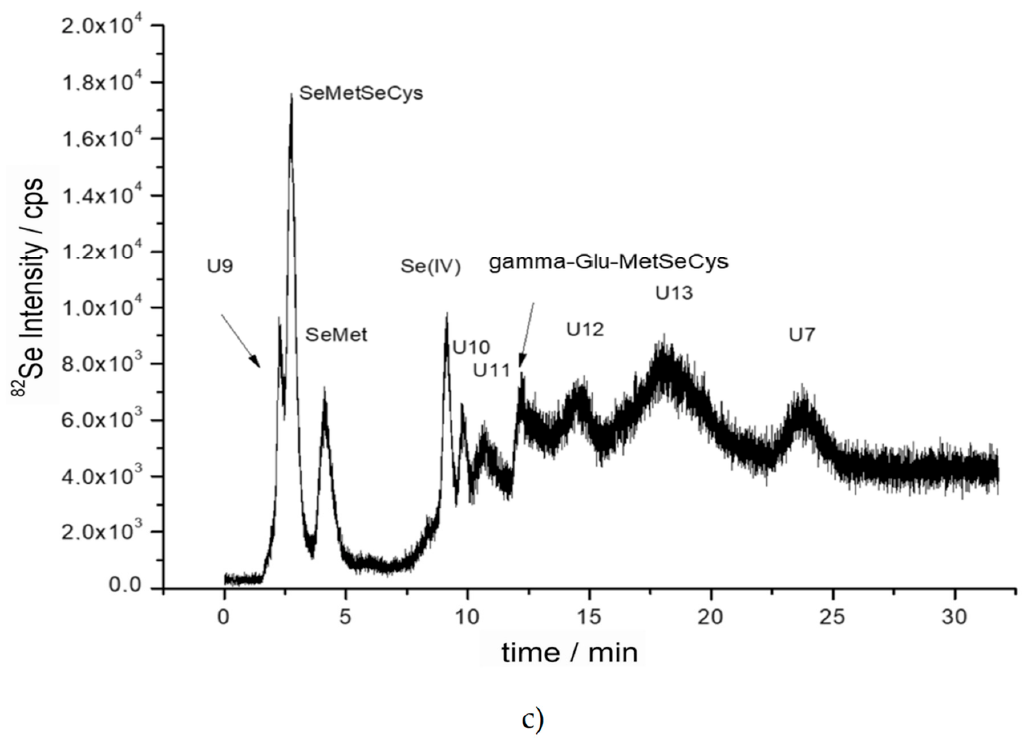
Figure 2. Chromatograms registered for extracts of ( a ) onion, ( b ) radish, and ( c ) sunflower sprouts, germinated in solutions containing 60 mg / L of Se as sodium selenite.